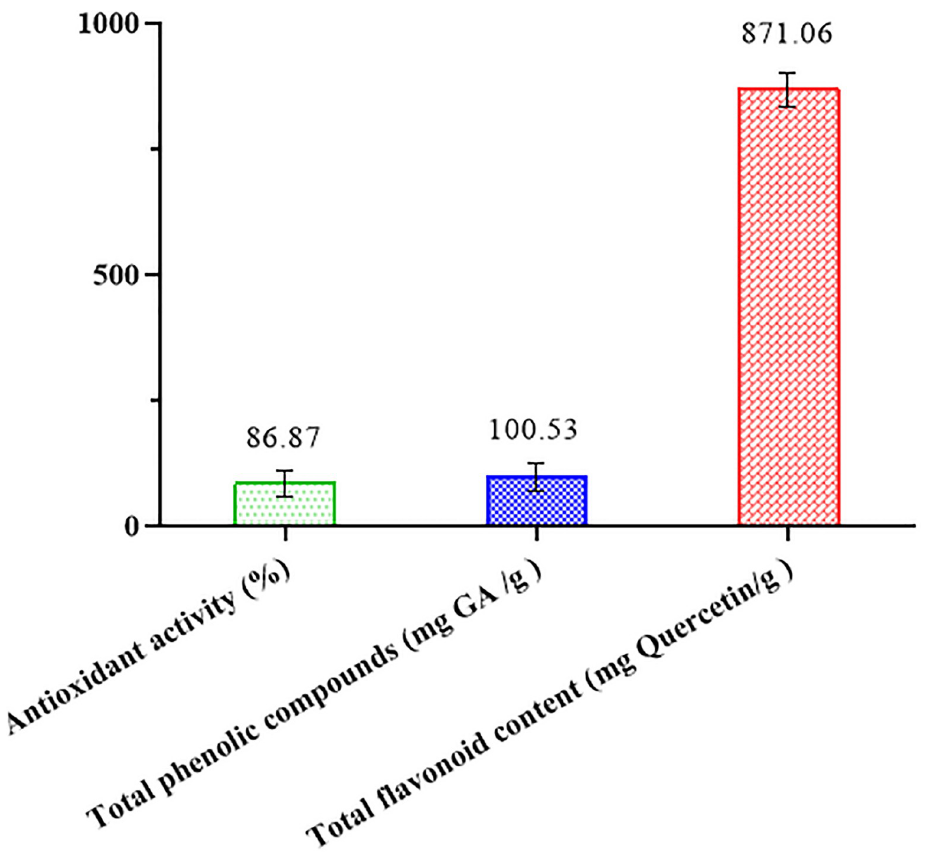
Fig 1. Antioxidant activity, total phenolic compounds and total flavonoid content of black plum peel.